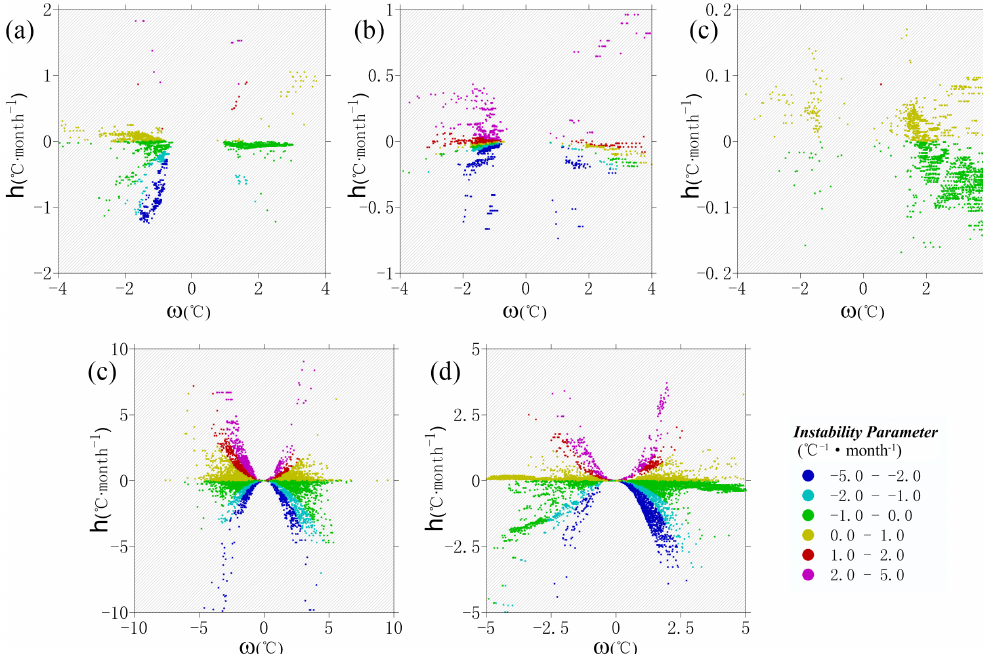
Figure 8. Relationship between abrupt change rate h and abrupt change amplitude parameter ω , and different colors represent different degrees by instability amplitude: (a–c) show the abrupt changes in 1878, 1942, and 1976; and (d–e) are the abrupt changes in 1890–1920,